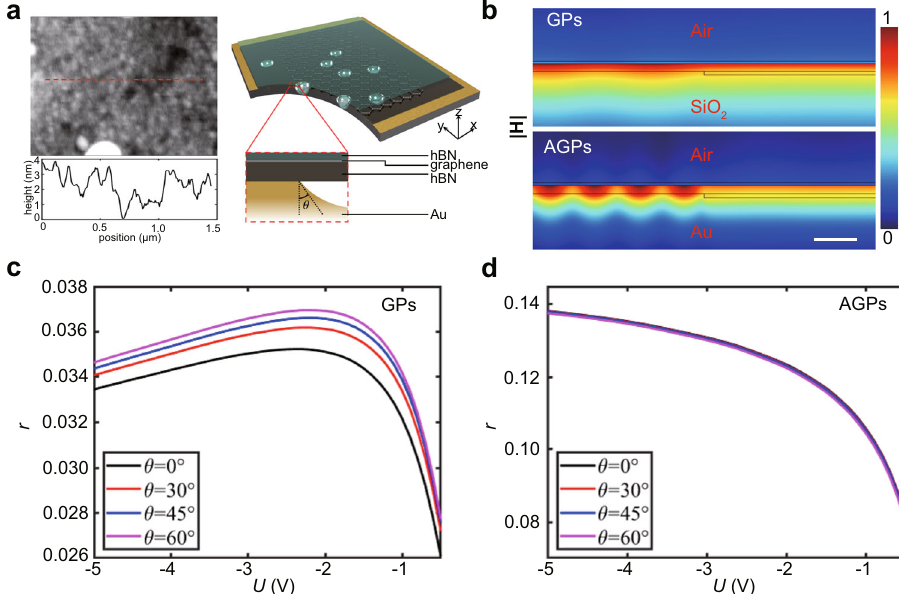
Fig. 2 The advantage of in-plane re fl ectivity of mid-infrared acoustic graphene plasmons (AGPs) compared to graphene plasmons (GPs). a Schematic diagram of the simpli fi ed calculation model. The left panels show the AFM topography of the h-BN/graphene/h-BN heterostructure placed on the gold surface, where a fl uctuation in a depth of about 3 nm exists. Deduced from the topographic differences between the sample and bare gold substrate, the height of the re fl ection boundaries is set as 3 nm. The angle θ is the angle between the surface normal and the tangent of boundary on the left side of hole. b The magnetic fi eld pro fi le of ∣ H ∣ during re fl ection at θ = 0 ∘ for GPs and AGPs. Scale bar, 30 nm. c , d Show back gate voltage U dependent re fl ectivity r of GPs and AGPs for different steepness of steps,